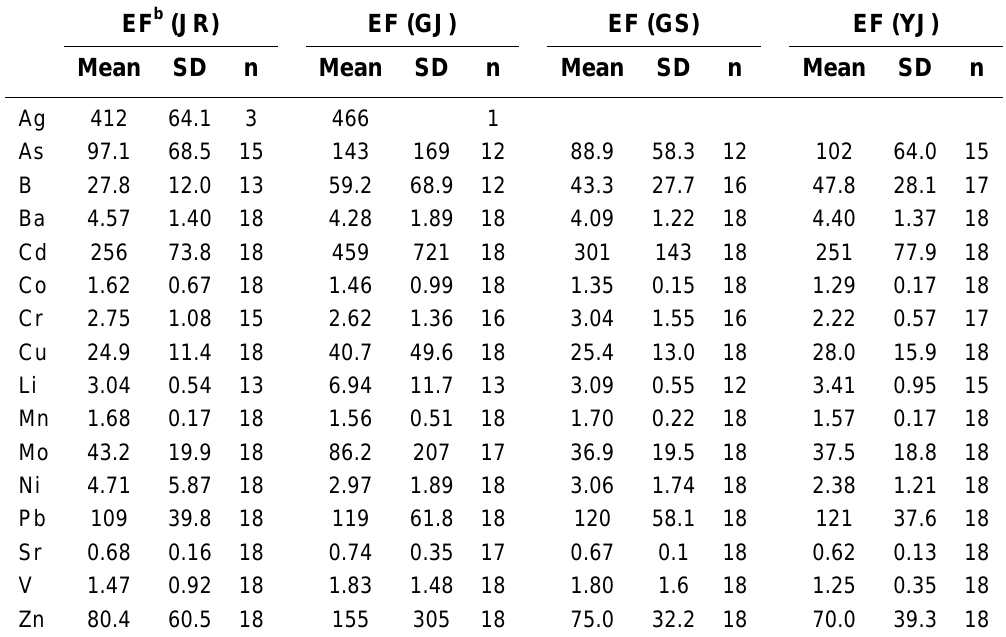
Statistical Summary of EF Values Derived using Metal Concentration of Four Sites in Seoul a